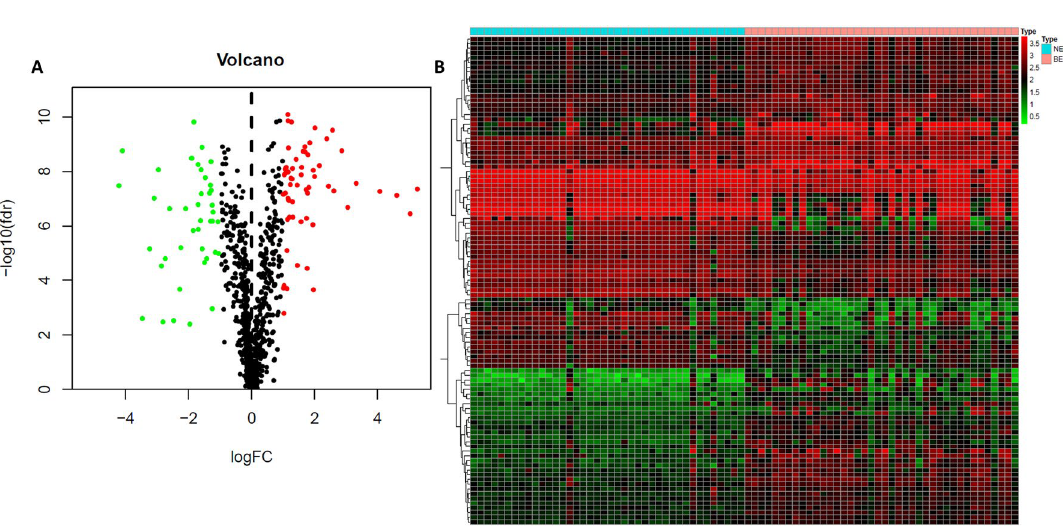
Figure 2. Identification of DEGs form GEO dataset. ( A ) The volcano plot of immune related DEGs between BE and NE samples. ( B ) The heatmap plot of immune related DEGs between BE and NE